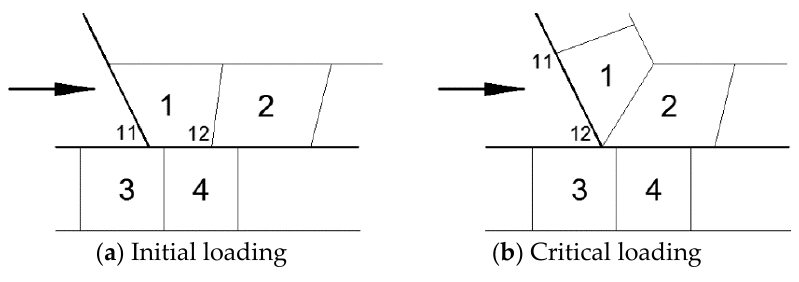
Figure 3. Pressure penetration criteria diagram.